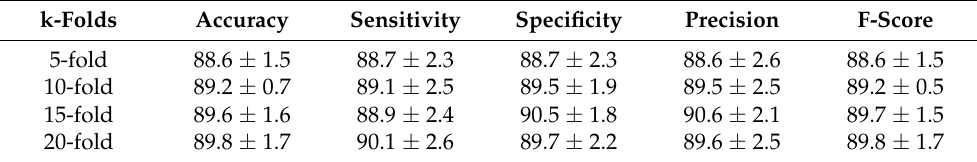
Table 4. Percentage of accuracy, sensitivity, specificity, precision, and F-score ( ± standard deviation) for binary classification of ASD vs. NC using k-fold cross-validation.